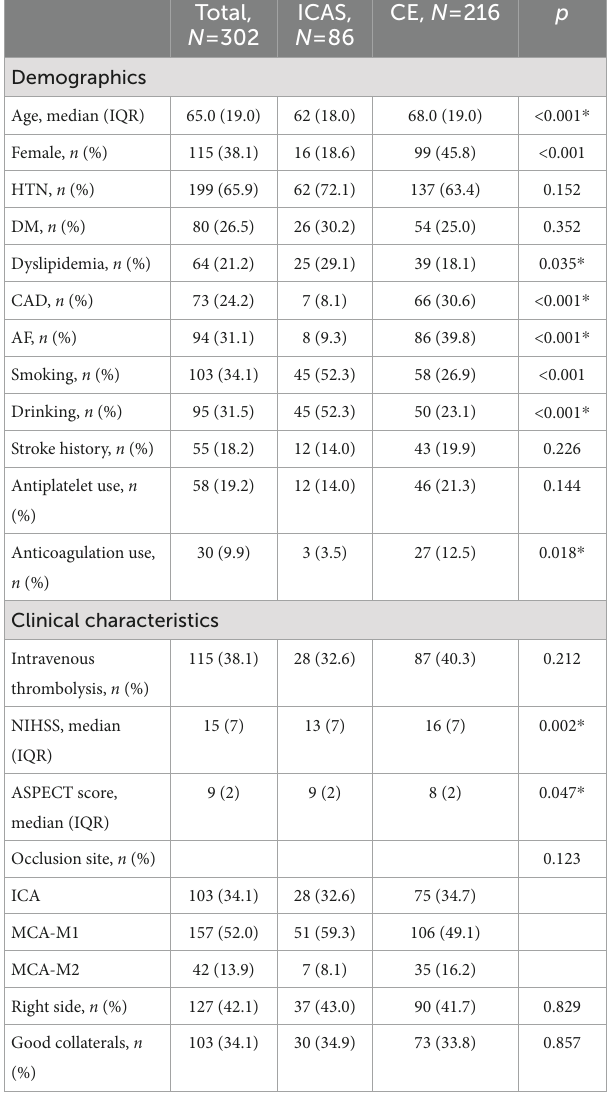
TABLE 1 Baseline characteristics of